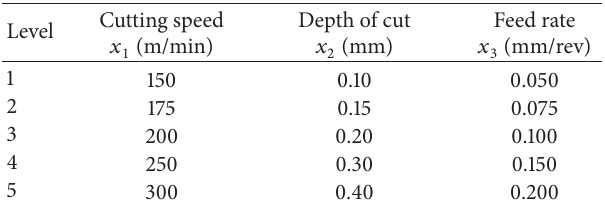
Table 2: Design variables values in five-level full-factorial